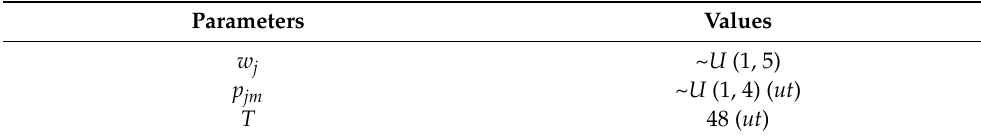
Table 6. Parameter